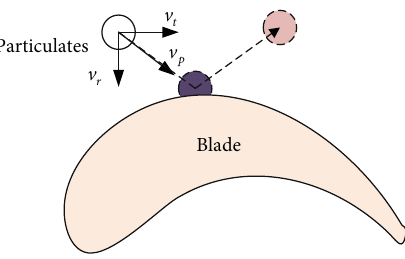
Figure 5: Particulate matter and blade surface contact process. Figure 6: Schematic diagram of contact between particle and blade based on JKR contact theory. Table 2: The mass of particles deposited on the blades. No.